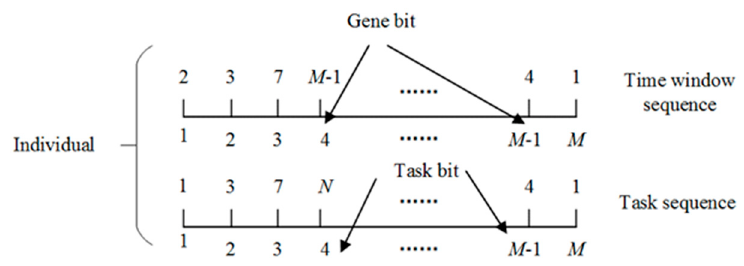
Figure 5. A diagram of coding method.